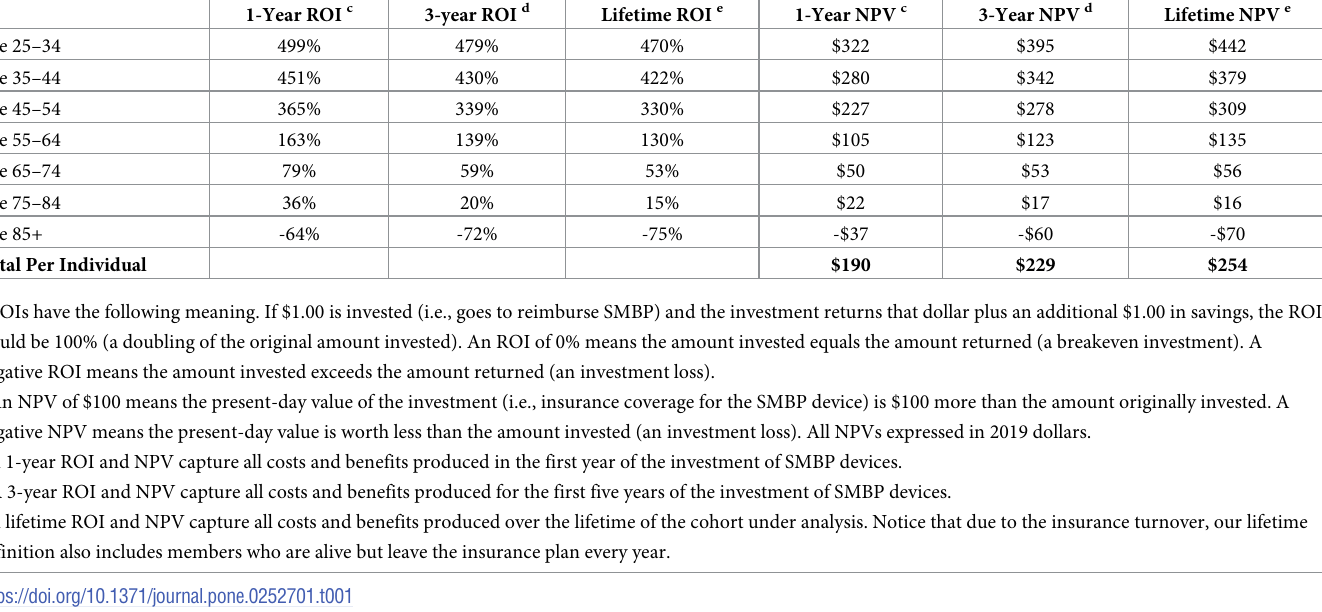
Table 2 presents NPVs by source of savings and by SMBP use case. Coverage of SMBP monitors is negative (-$127 per individual) since this represents a cost. Costs are offset by sav- ings, expressed as NPVs associated with: (a) hypertension diagnosis, treatment selection and dosage titration (saving $210 per individual when SMBP is used), (b) ongoing HTN treatment monitoring (saving $202 per individual), (c) treatment of future hypertension-related CVDs (saving < $1 per individual), and (d) premiums paid to the insurance plan by surviving plan members (saving < $1 per individual). The last three columns in Table 2 show NPVs broken down by SMBP usage. NPVs are posi-